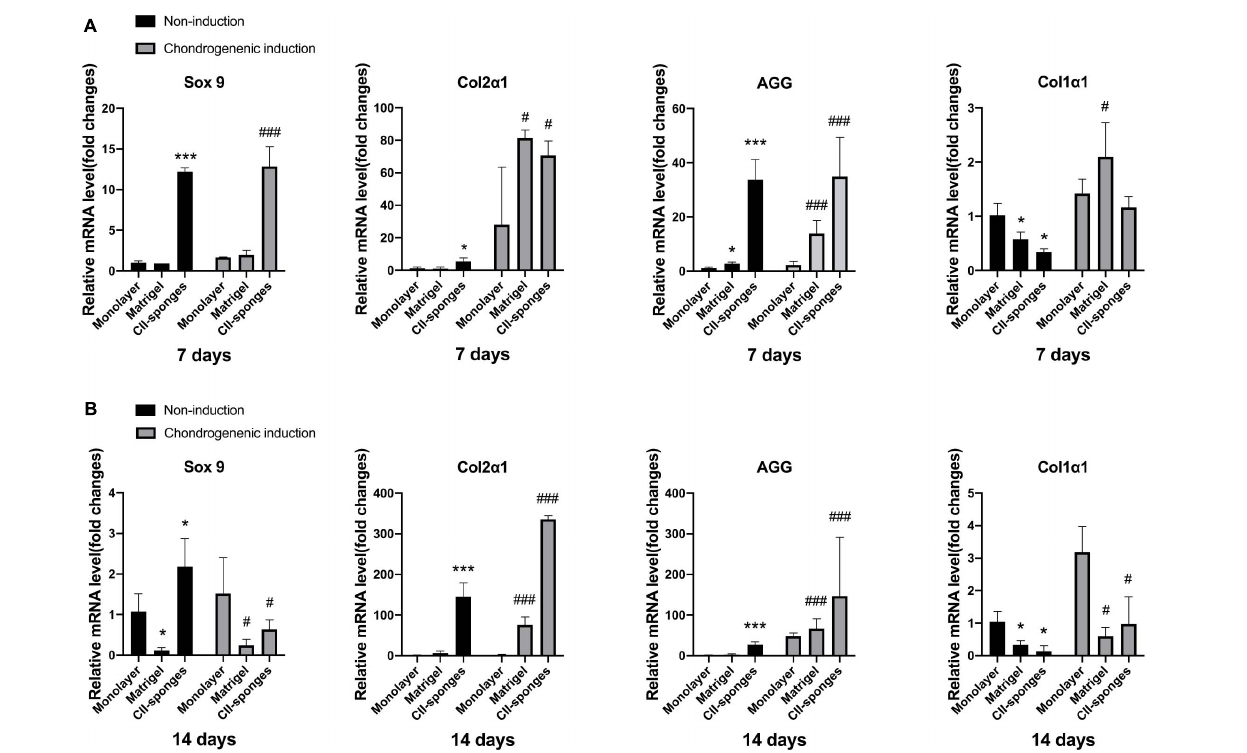
FIGURE 3 | The fibrochondrocytes related genes expression with or without chondrogenic induction. (A) The mRNA levels of chondrogenic genes, including Sox 9, Col2 α 1 and AGG, and fibroblastic gene, Col1 α 1, in TSPCs seeded in monolayer, Matrigel, or CII-sponges for 7 days with or without chondrogenic induction. (B) The mRNA levels of chondrogenic genes, including Sox 9, Col2 α 1 and AGG, and fibroblastic gene, Col1 α 1, in TSPCs seeded in monolayer, Matrigel, or CII-sponges for 14 days with or without chondrogenic induction. * or # represented p (cid:53) 0.05, and *** or ### represented p (cid:53)